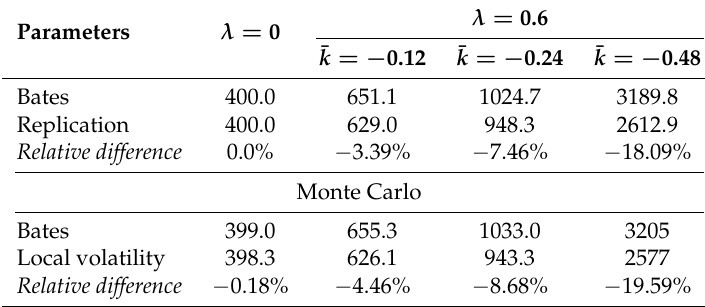
Table 8. Evolution of variance swap prices under extreme Bates parameters, varying the jump